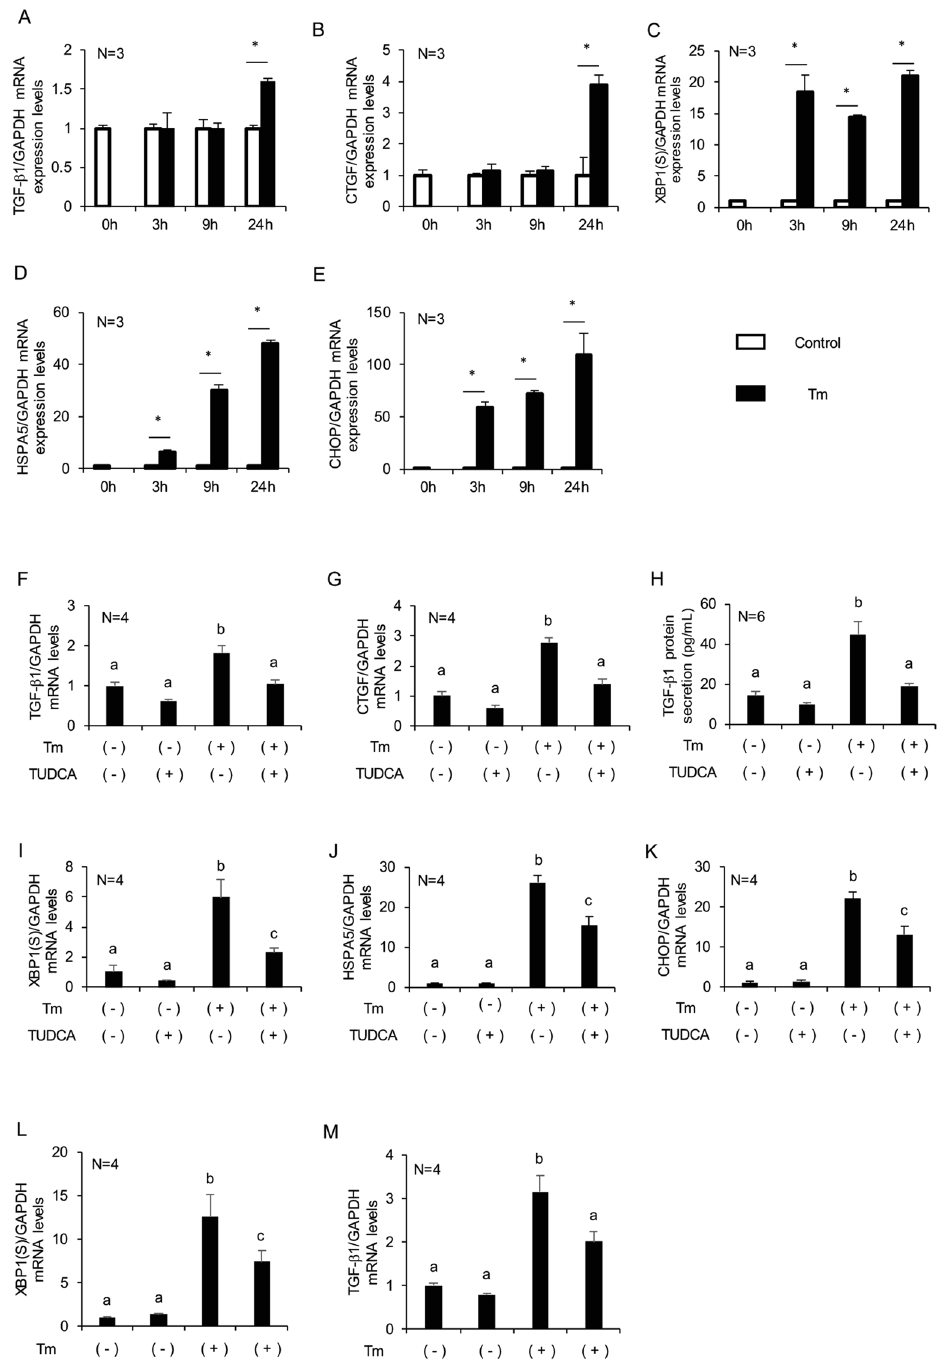
Figure 4. Effects of ER stress on TGF- β 1 and CTGF mRNA expression levels and TGF- β 1 secretion by cultured human granulosa-lutein cells. ( A – E ) Granulosa-lutein cells were treated with tunicamycin at 2.5 μ g/mL for 0, 3, 9, or 24 h. ( F – K ) Granulosa-lutein cells were pre-incubated with TUDCA at 1 mg/mL for 24 h, followed by treatment with tunicamycin at 2.5 μ g/mL for 24 h. ( L,M ) Granulosa-lutein cells were transfected with siRNA (50 nM) or negative control siRNA (50 nM) for 24 h and then, treated with tunicamycin (2.5 μ g/mL) for 24 h. ( A , F , M ) TGF- β 1, ( B , G ) CTGF, ( C,I,L ) XBP1(S), ( D , J ) HSPA5, and ( E , K ) CHOP mRNA expression levels in granulosa-lutein cells were measured by real-time PCR and normalized to that of GAPDH. The values represent means ± SEM of triplicate or quadruplicate experiments, relative to the mean control value. ( H ) The bioactive TGF- β 1 level in cultured cell supernatants was measured by ELISA. The values represent means ± SEM of sextuplicate experiments. The results are representative of at least three independent experiments using three different samples. The letters denote significant differences between groups. * p < 0.05. Tm, tunicamycin; TUDCA, tauroursodeoxycholic